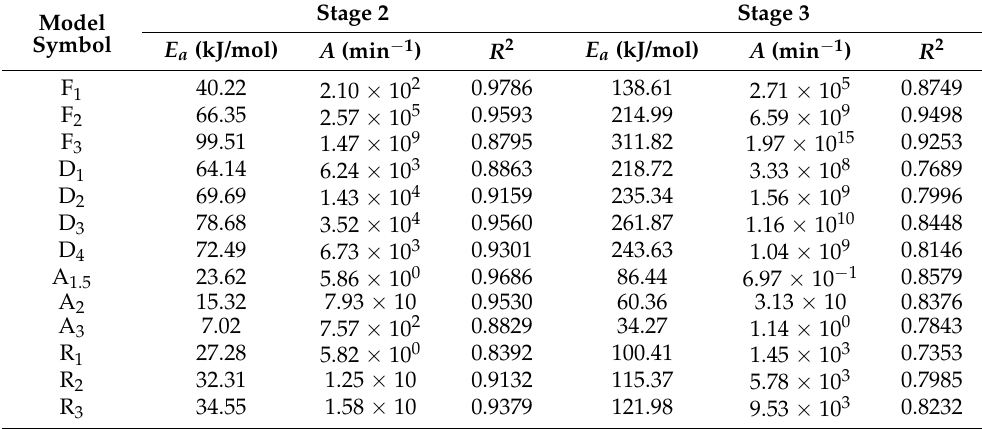
Table 6. E a , A , and R 2 in various mechanism models calculated by the Coats–Redfern